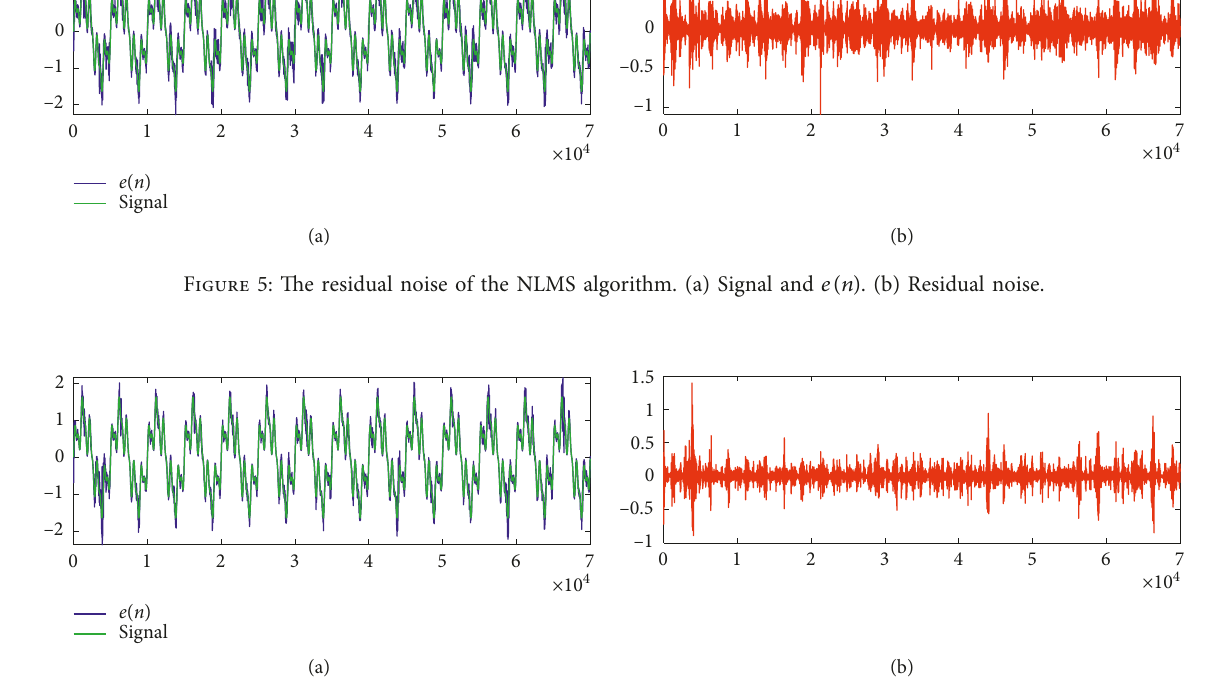
Figure 6: The residual noise of the improved LMS algorithm. (a) Signal and e